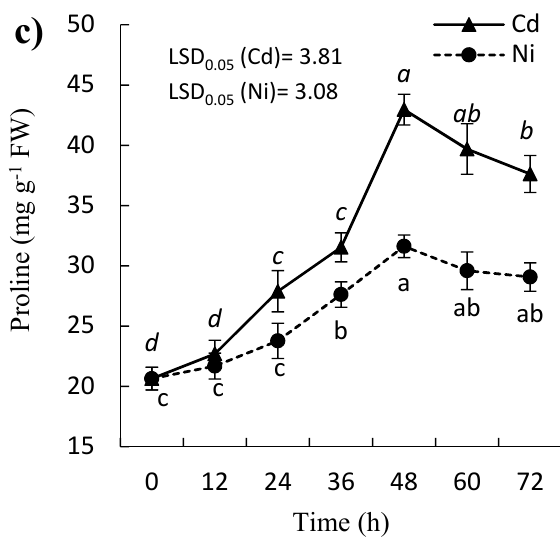
Figure 5. Effect of Cd and Ni on the content of ( a ) protein ( b ) phenolics, and ( c ) proline in the leaves of P. sativum with time. Different letters per each line mean a significant difference ( p ≤ 0.05 ). Values are average of means ( n = 6 ) and bars represent the standard error. LSD 0.05 is the least significant difference at the probability level of 0.05.